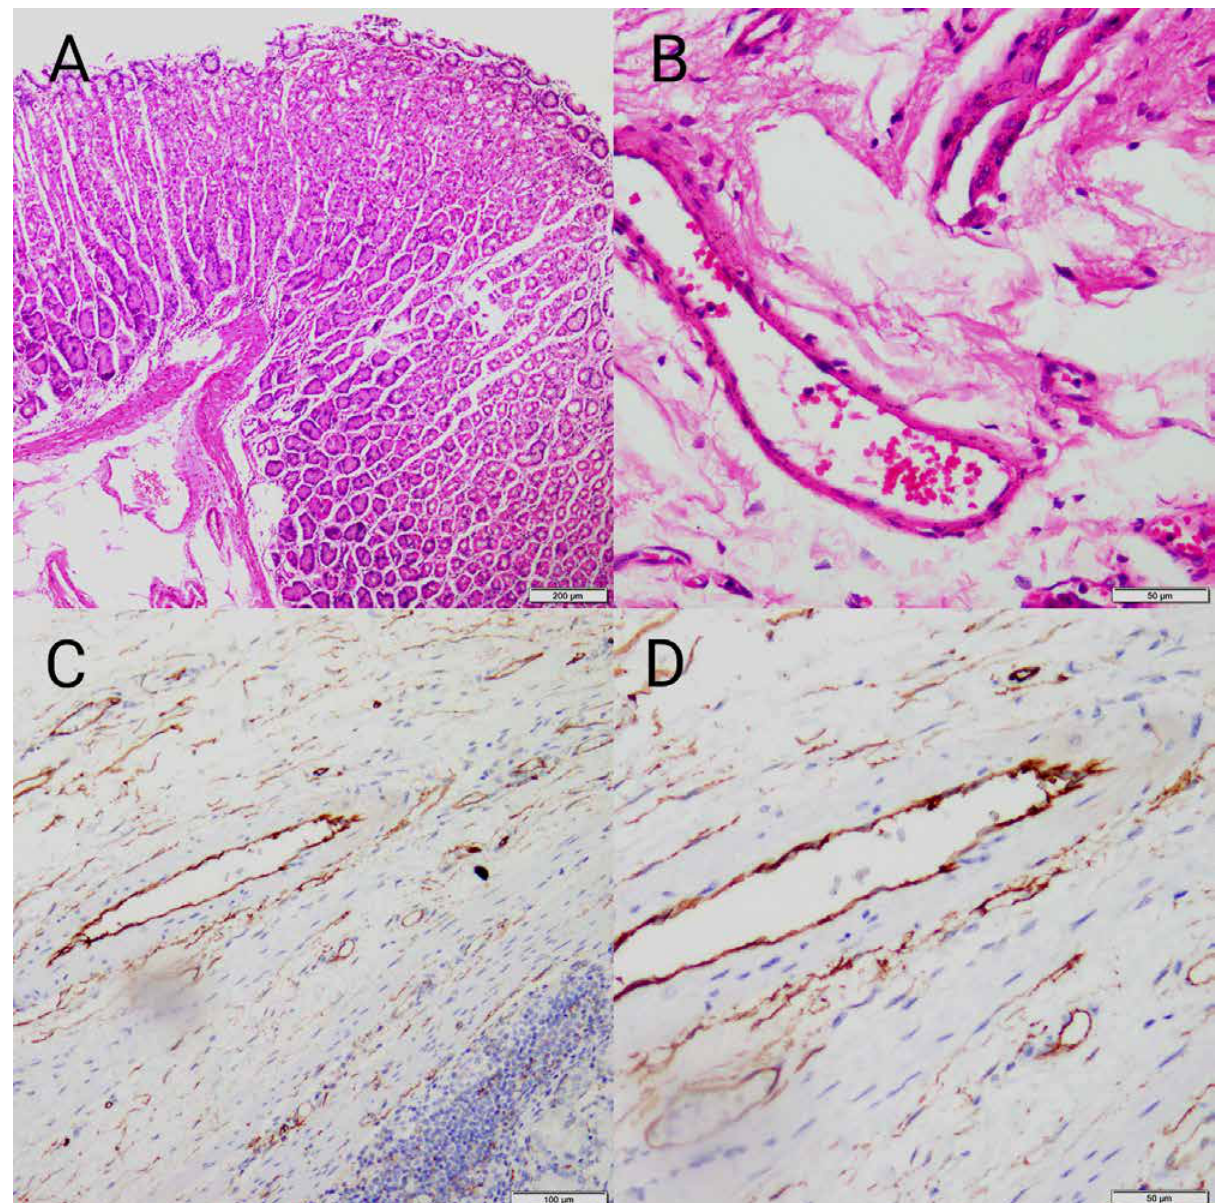
Figure 4: Histopathologic and immunohistochemical expression of normal tissues. A. HE×40. Covered with maturely differentiated mucosal epithelium. The submucosa consisted of loose fibrous connective tissue. B. HE×400. The wall of small vessels in the submucosa was thin and surrounded by fibrous cells and adipocytes. C. CD34. Immunohistochemical findings revealing vascular endothelial cells stained positive for CD34(normal cells +) × 100. D. CD34. Immunohistochemical findings revealing vascular endothelial cells stained positive for CD34(normal cells +) ×